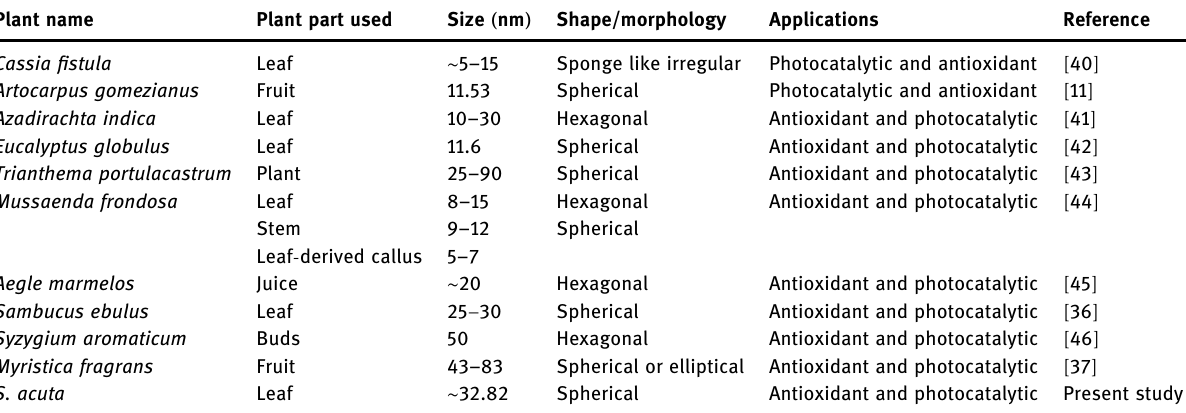
Table 1: Morphology of plant - mediated ZnO NPs and their applications Plant